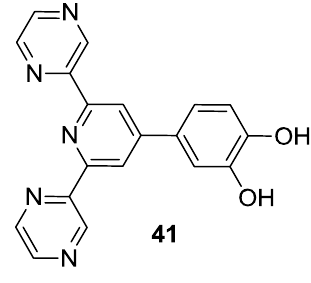
Figure 31. Example of dipyrazinyl-pyridine ligand [135].